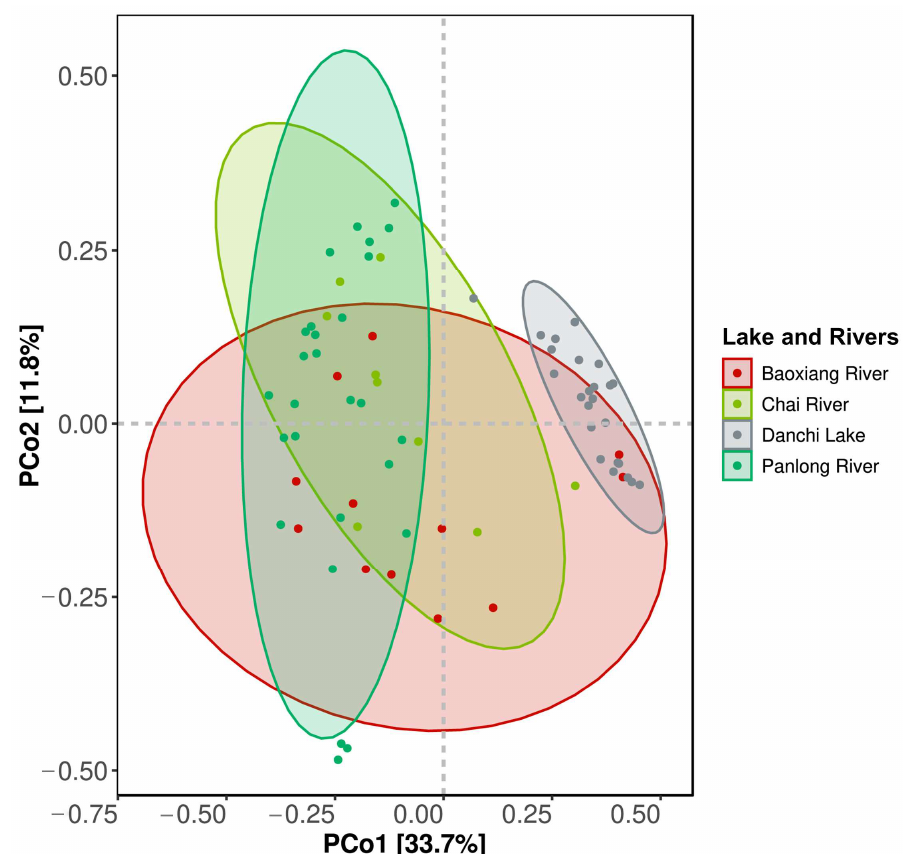
Figure 4. Principal coordinates analysis (PCoA) of the composition of the fish community of Dianchi Lake and the three inflowing rivers. Table 2. PERMANOVA test results of the three inflowing rivers in Dianchi Lake basin. Group Fish